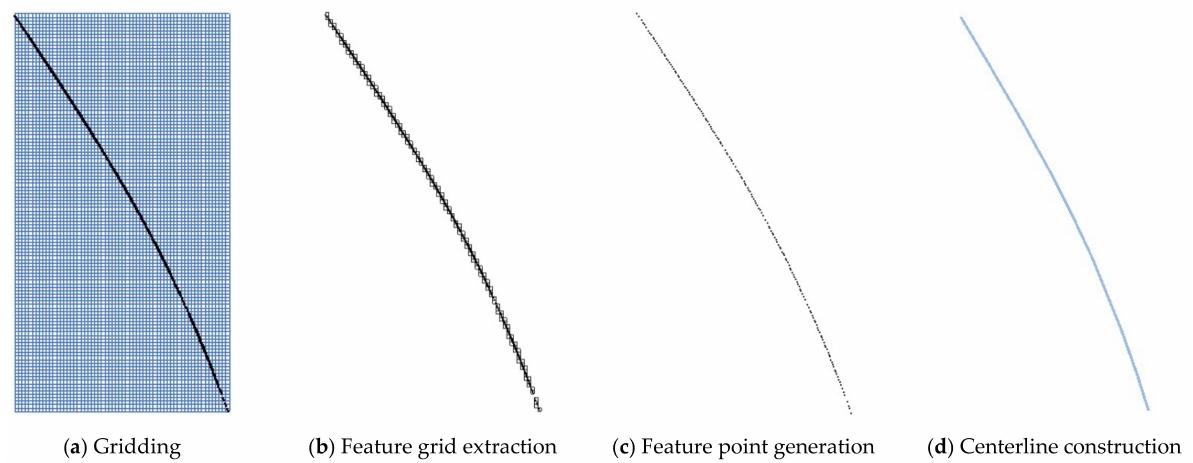
Figure 6. Feature point generation and curve approximation.